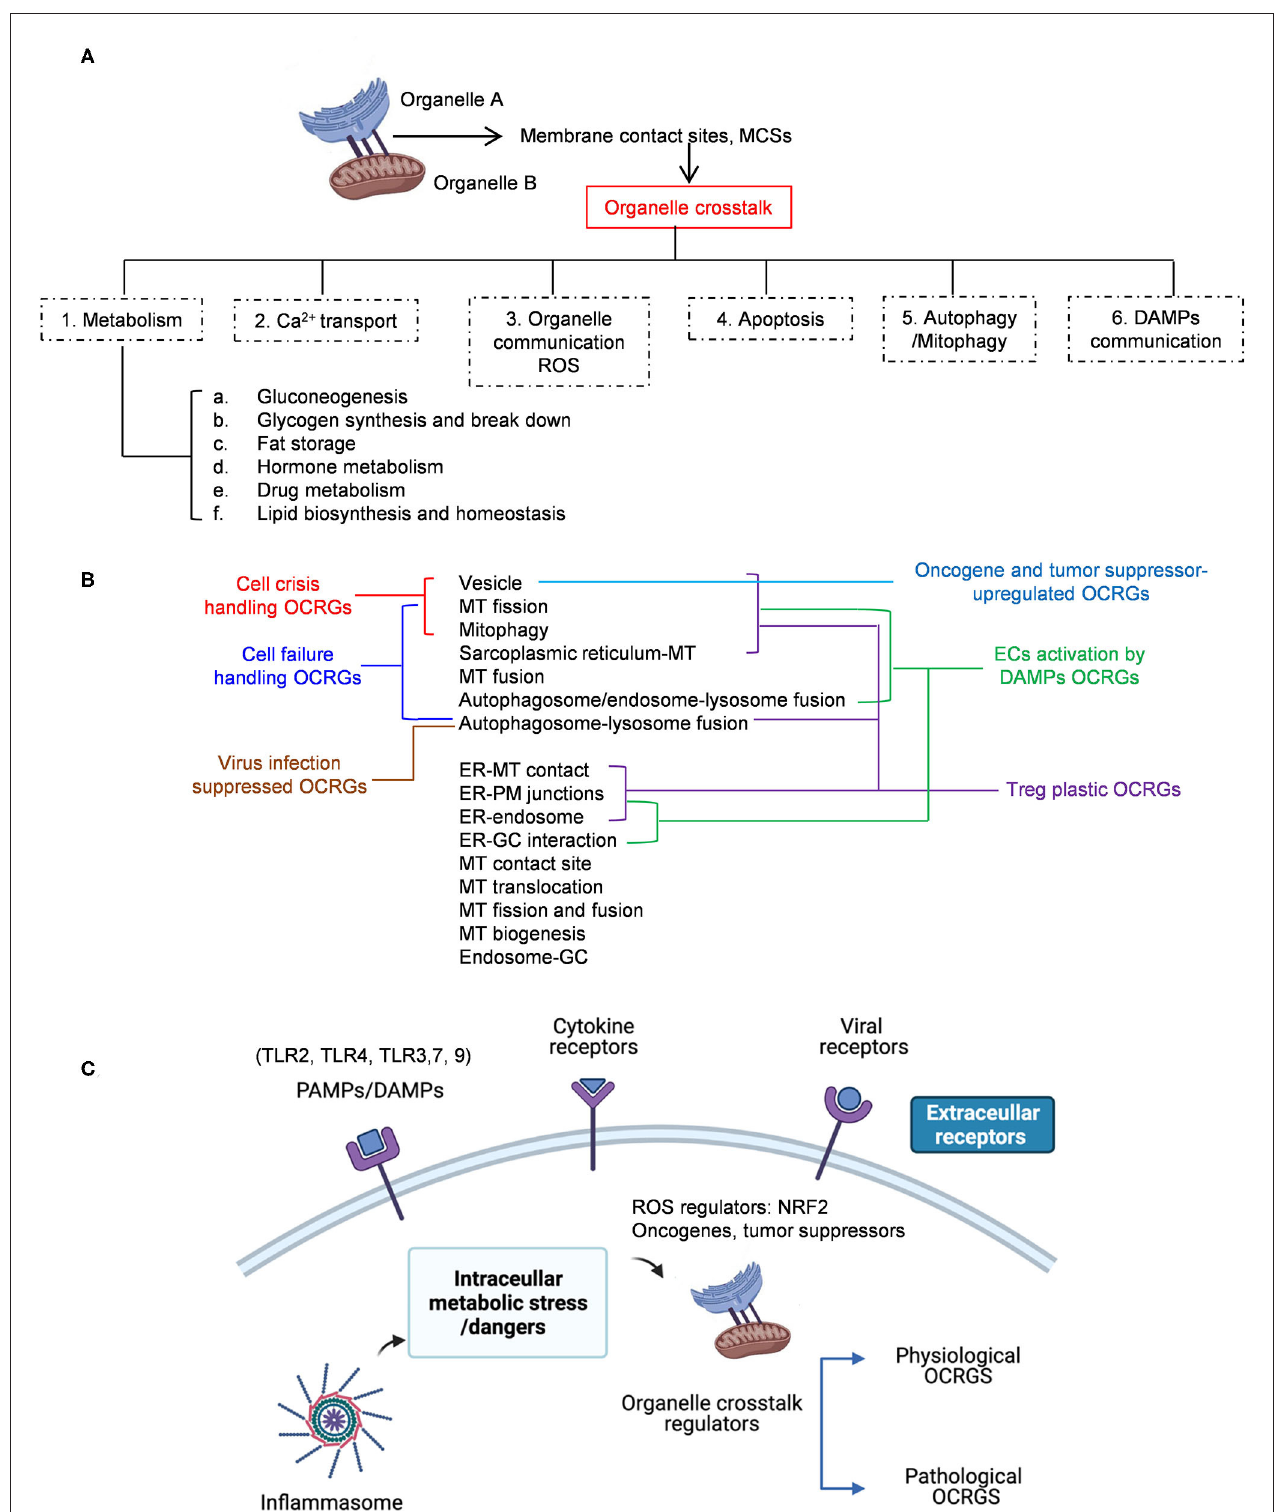
FIGURE 11 | A novel working model shows the function, classification, and regulated mechanisms of OCRGs in diseases, and DAMP- and virus-treated cells. (A) The membrane contact sites between two organelles, at least between ER and mitochondria (Mito, MT), have been found to play several significant functions from